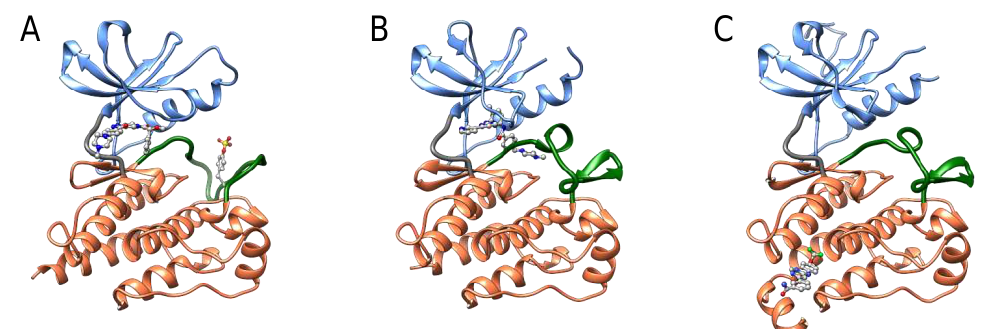
Figure 5. Ribbon representation of ABL kinase domains complexed with the indicated inhibitors. The inhibitors are presented as ball and stick models. The colors indicate the same regions shown in Figure 1. Complexes with the type I kinase inhibitor PHA-739358 ( A ), type II inhibitor imatinib ( B ), and type III inhibitor GNF-2 ( C ) are illustrated from PDB IDs 2V7A, 2HYY, and 3K5V, respectively. PHA-739358 and imatinib bind to the ATP-binding cleft of the active DFG-in state and the inactive DFG-out state, respectively. Imatinib binds behind the activation loop (green) in the ATP pocket ( B ). GNF-2 binds to the allosteric site in the C-lobe (orange).